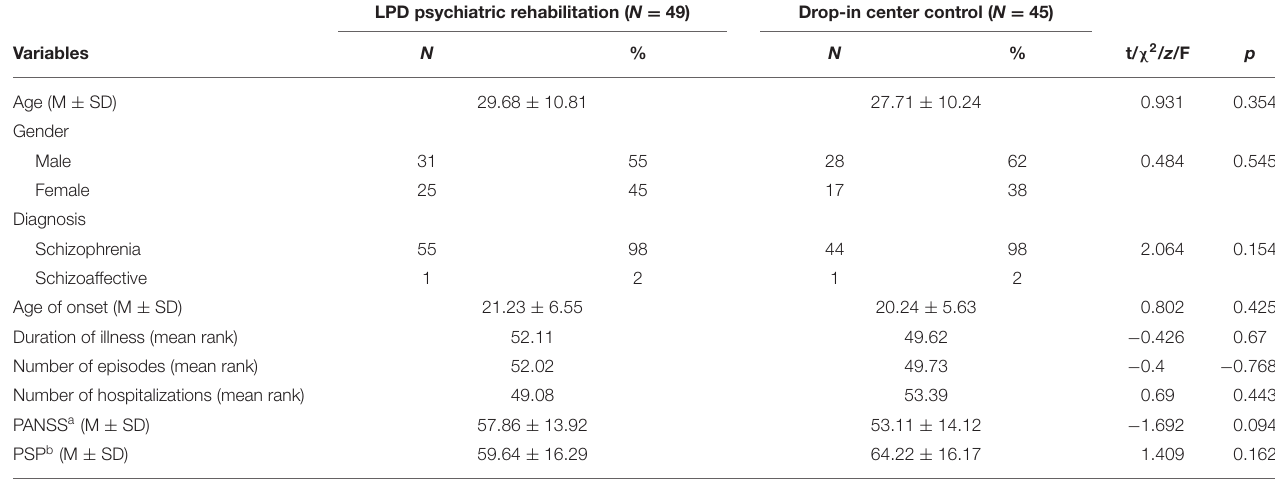
TABLE 2 | Sample characteristics, total